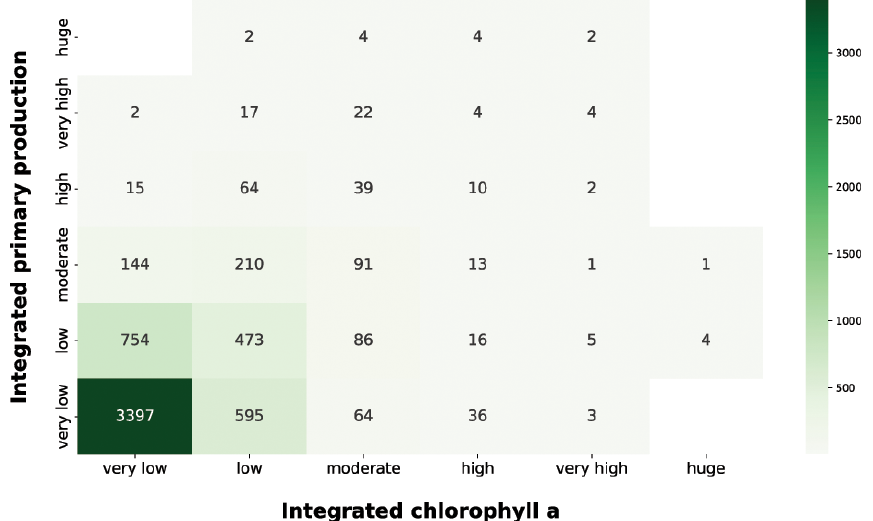
Figure 15. IPP vs. chlorophyll a . The green heatmap relates the depth-integrated phytoplankton production to the chlorophyll a magnitude, which is one of the most used proxies for phytoplankton